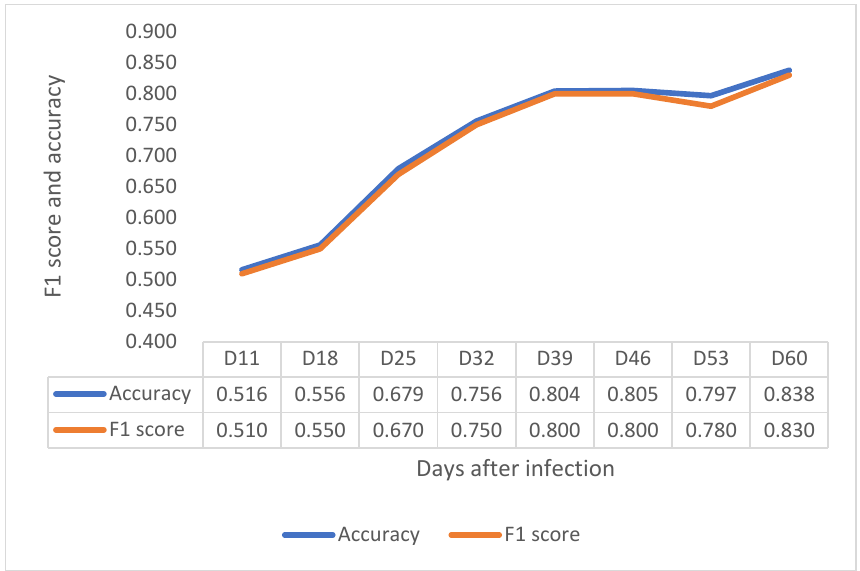
Figure 6. Depiction of F1 score and accuracy of the SWIR sensor from 11 to 60 DAI.